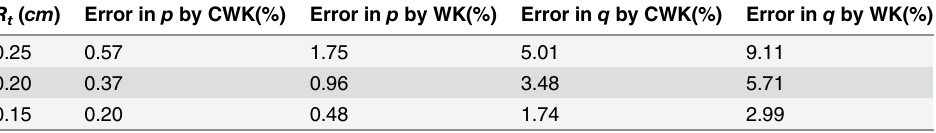
Table 3. Average modeling errors of blood pressure and flow rate induced by the CWK and WK mod- els in large arterial